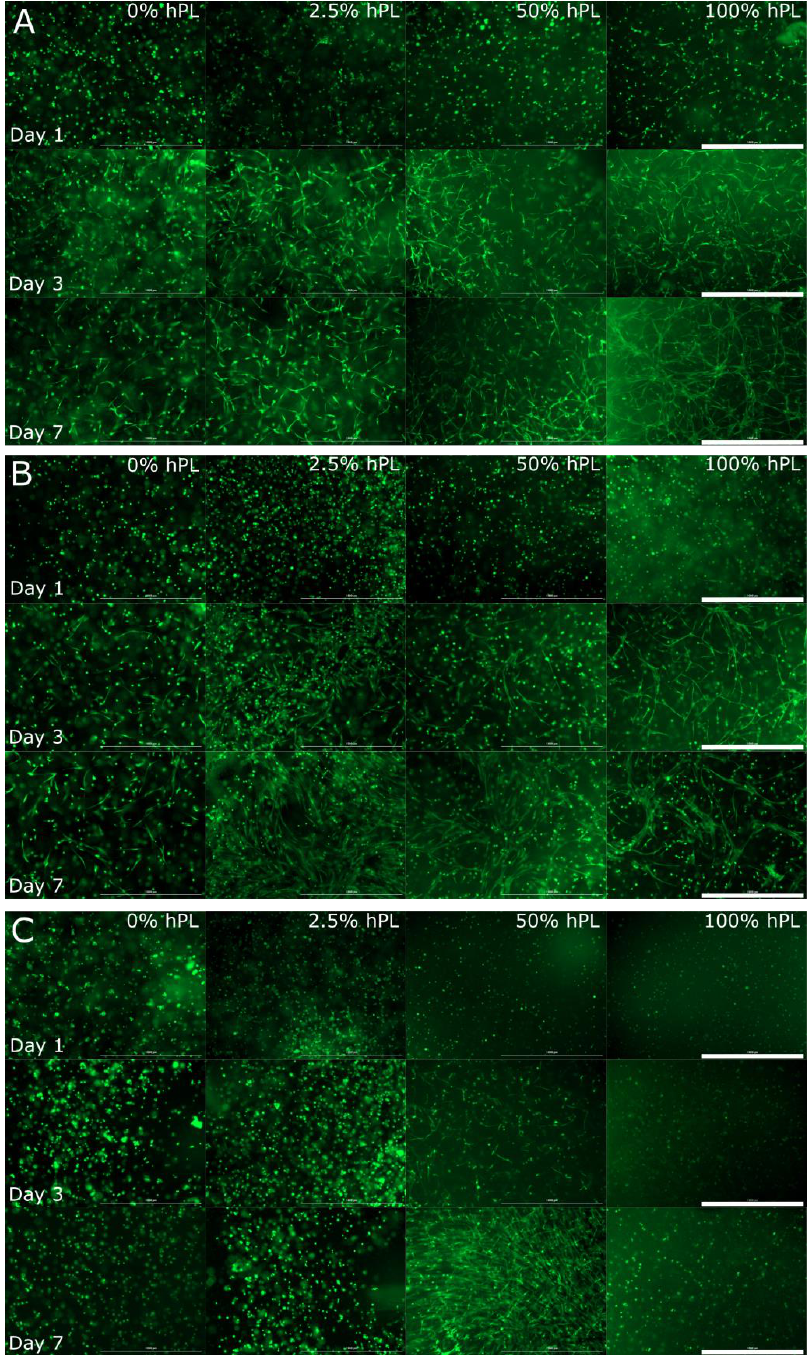
Figure 1. Morphological examination of AD-MSCs encapsulated with a UV dose of 1.2 J/cm 2 in 5% GelMA with ( A ) 50% degree of functionalization (DoF), ( B ) 70% DoF, and ( C ) 95% DoF, formulated with 0, 2.5, 50, and 100% human platelet lysate (hPL). After cultivation of 1, 3, and 7 days, the cells were stained with calcein-AM; 4 × objective, scale bar 1000 µ